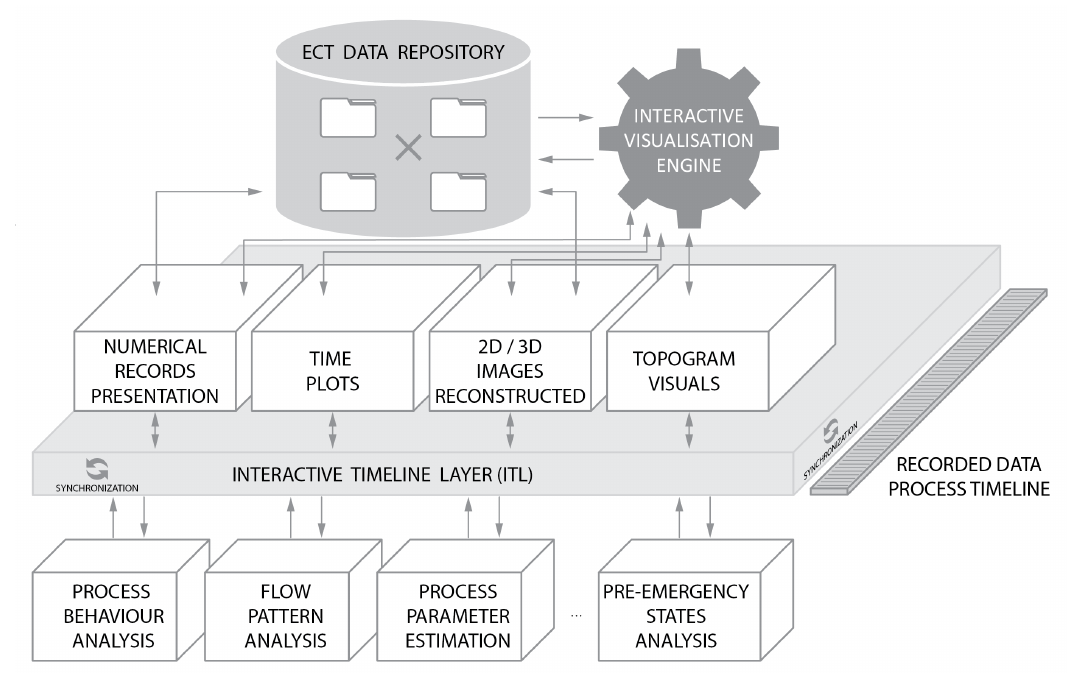
Figure 4. Schematic diagram of the Interactive timeline synchronization mechanism. Top layer serves as both: the ECT data repository as well as the engine serving requests for particular visuals. Visuals layer (second from the top) is bounded to the central Interactive Timeline Layer (ITL) that synchronizes the requested visuals with the corresponding time stamp of the process as recorded in the measurement data. Bottom layer represents particular purpose of the analysis that makes use of the ITL in accordance with the specific needs.